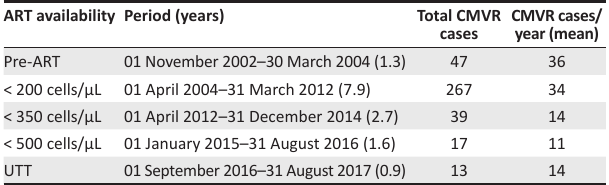
TABLE 2: Cytomegalovirus retinitis cases in correlation with antiretroviral treatment availability in eThekwini from 01 November 2002 to 31 August 2017. ART availability Period (years)